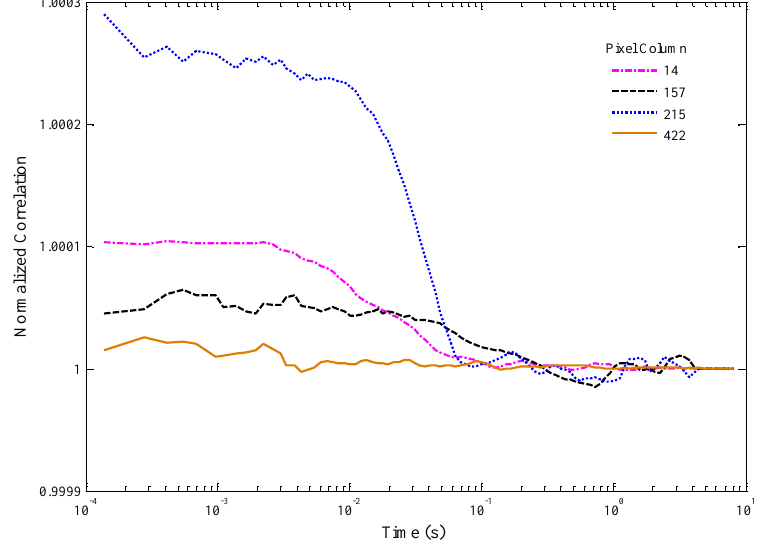
Figure 8. Normalized autocorrelation functions for selected columns of experimental data in Figure